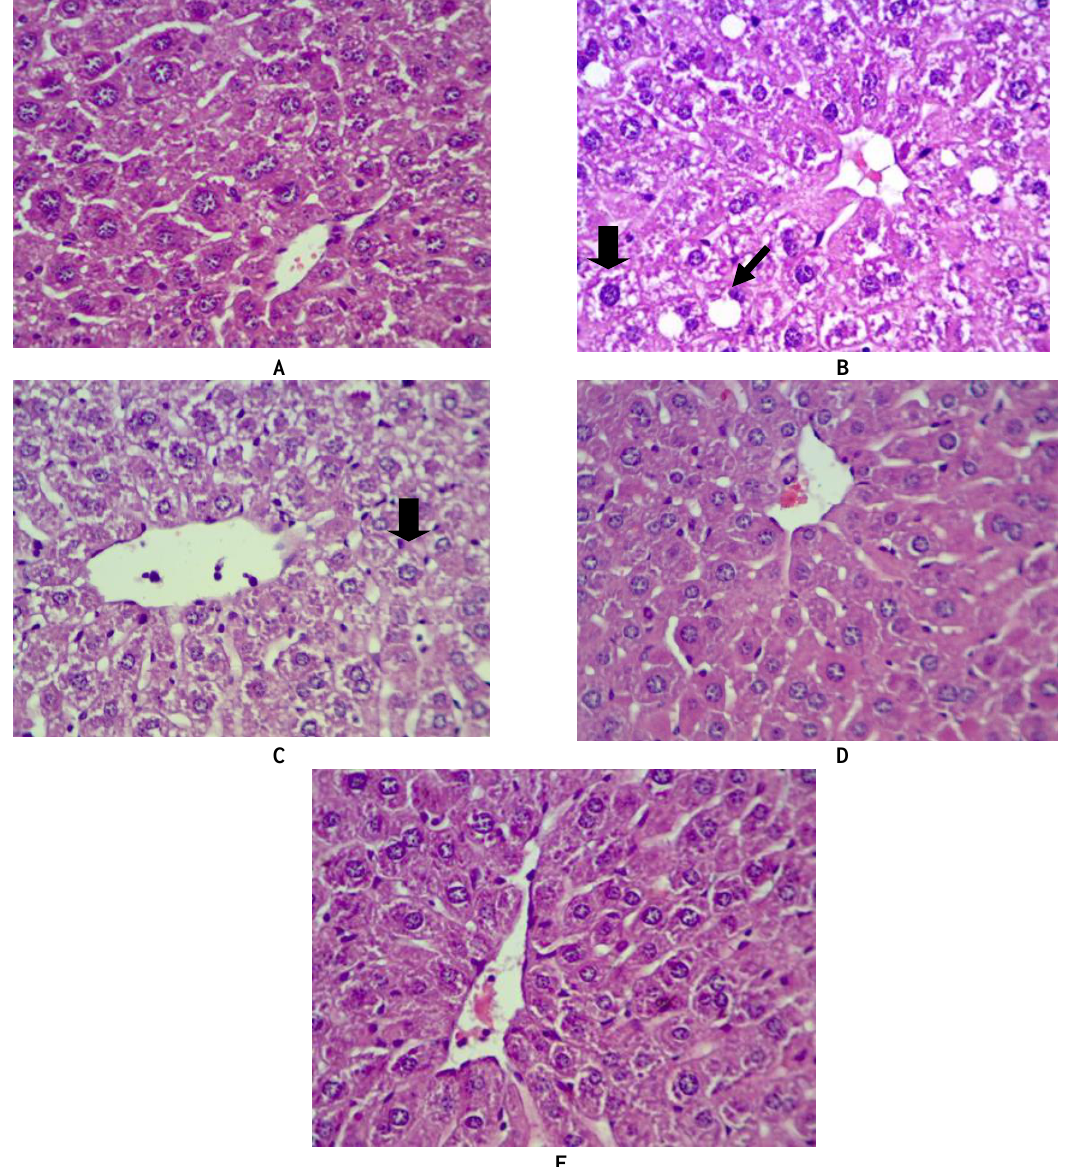
Figure (11) Histological assessment of NASH activity score (steatosis, inflammation and ballooning degeneration). Representative H and E stained sections from; control (A), HFD (B), GS 500ppm (C), GS 1000ppm (D) and GS 2000ppm (B), mouse models.A variable size of clear, optically empty,unstained fat vacuoles microvesicular (Thick arrow) and macrovesicular (Thin arrow) fatty